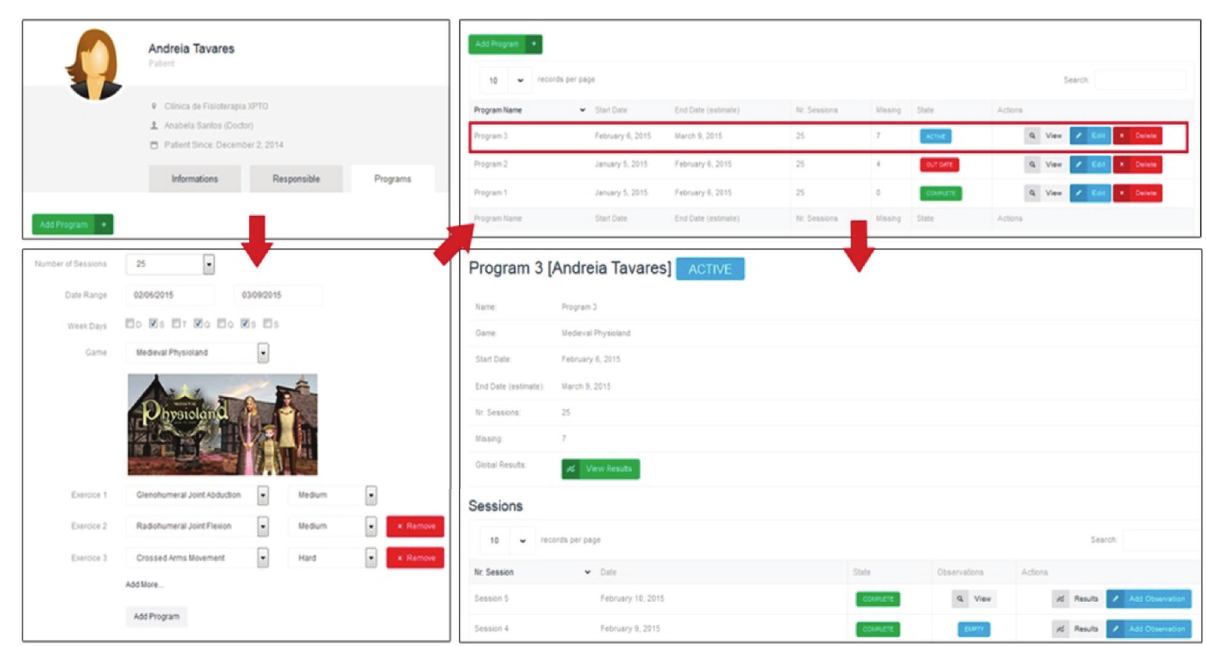
Figure 10: Creating process of a physical therapy program for a particular